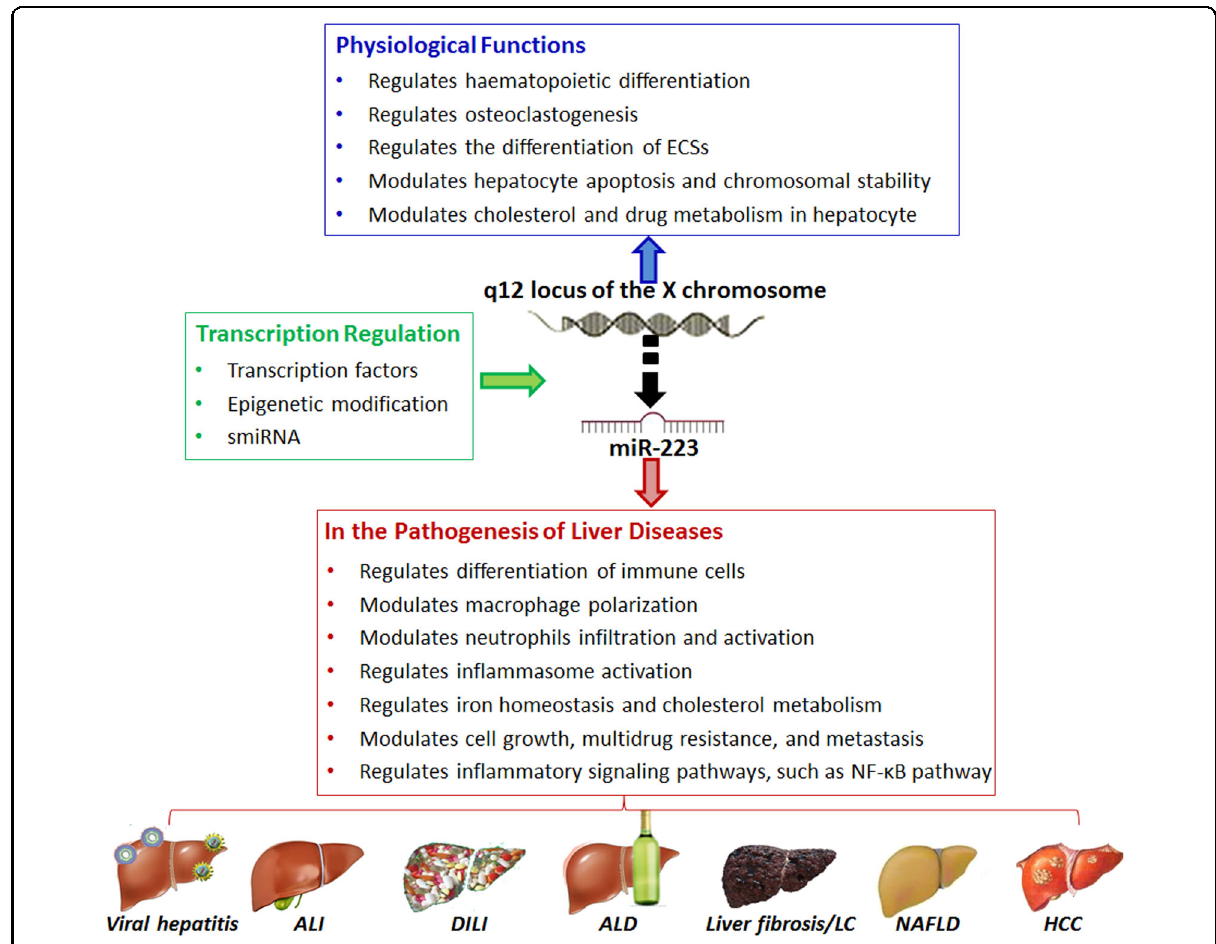
condition, including hematopoietic differentiation, osteoclastogenesis, embryonic stem cell (ESC) differentiation, cell apoptosis, chromosomal stability, hepatic cholesterol metabolism, and hepatic drug metabolism. MiR-223 is also involved in the pathogenesis of various liver diseases by in fl uencing immune cell differentiation, neutrophil in fi ltration, macrophage polarization, in fl ammasome activation, iron homeostasis,